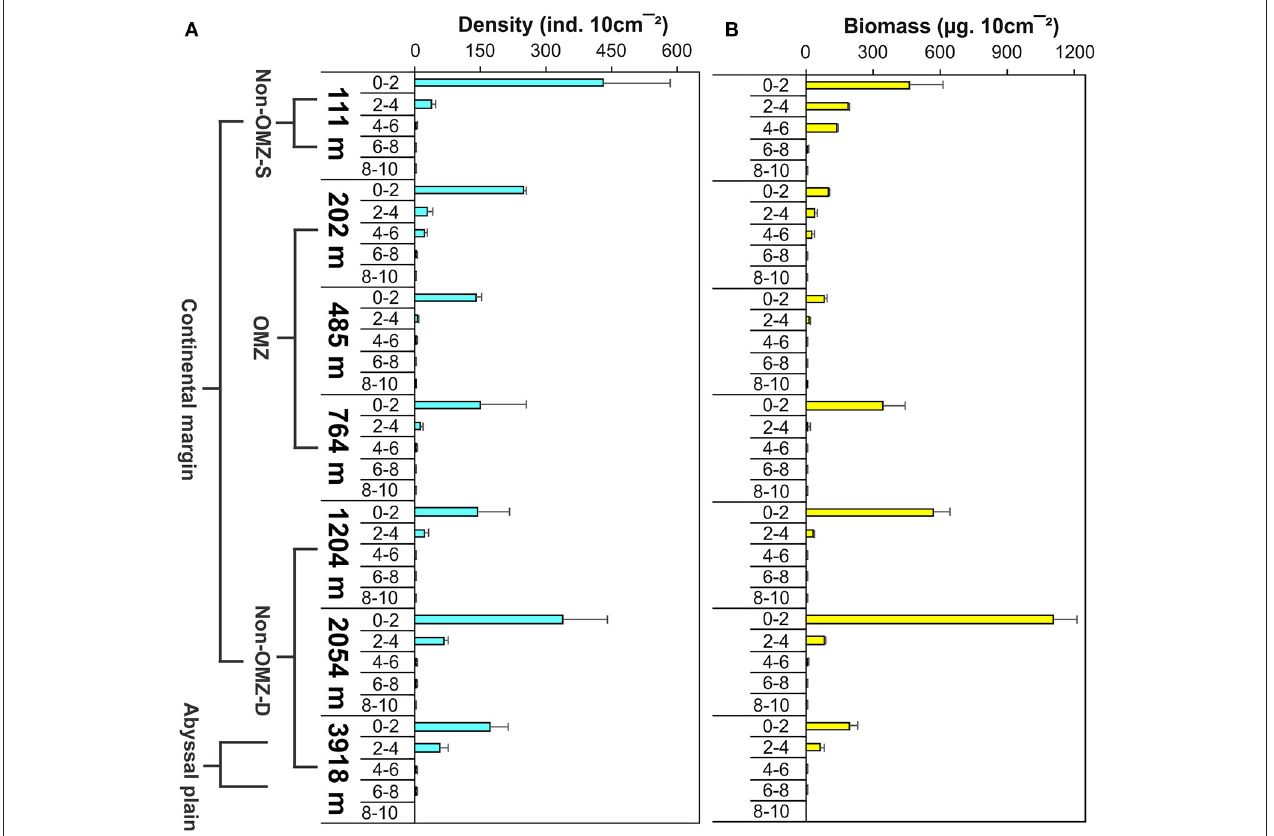
FIGURE 8 | Vertical distribution of meiofauna within the sediment column along WICM and abyssal plain. (A) Meiofaunal density and (B) Meiofaunal biomass.